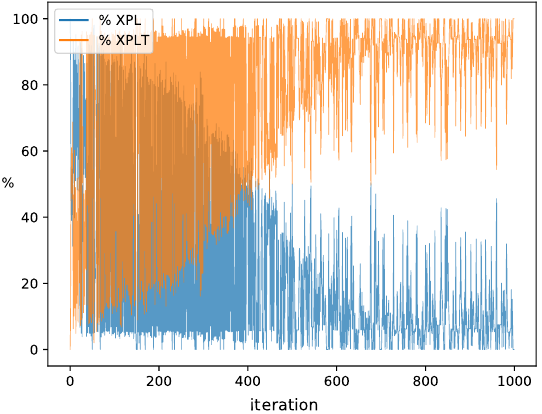
Figure 13. WOA—Exploration and Exploitation Graphic of 58 version